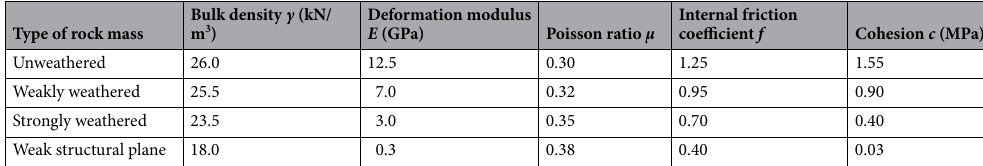
Table 4. The parameters for numerical